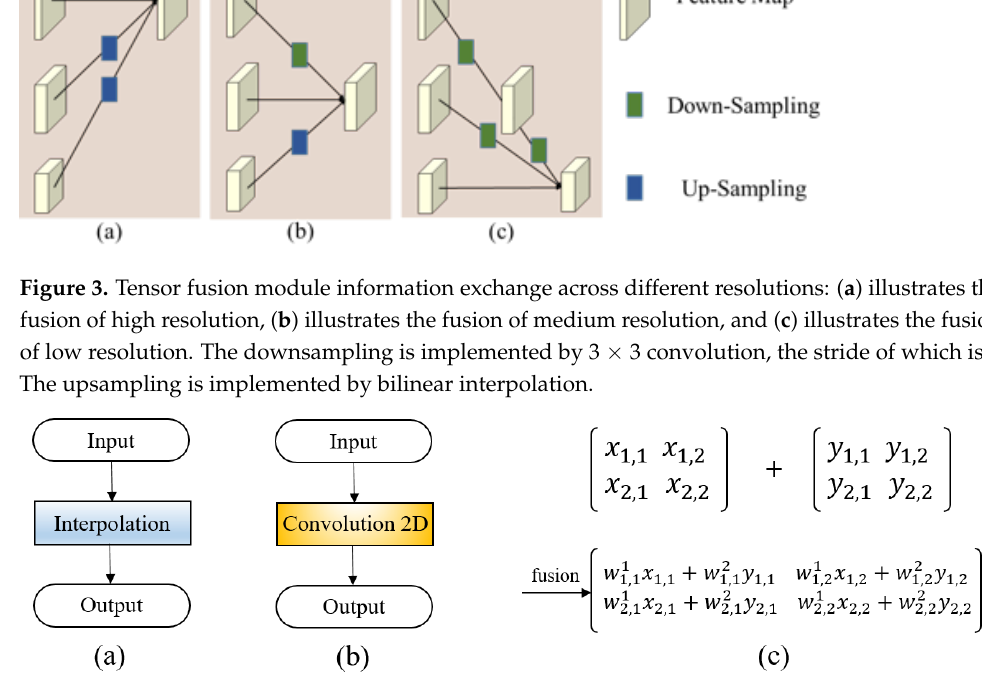
Figure 4. The fundamental processes involved in the network: ( a ) diagram of upsampling, ( b ) dia- gram of downsampling, and ( c ) diagram of tensor